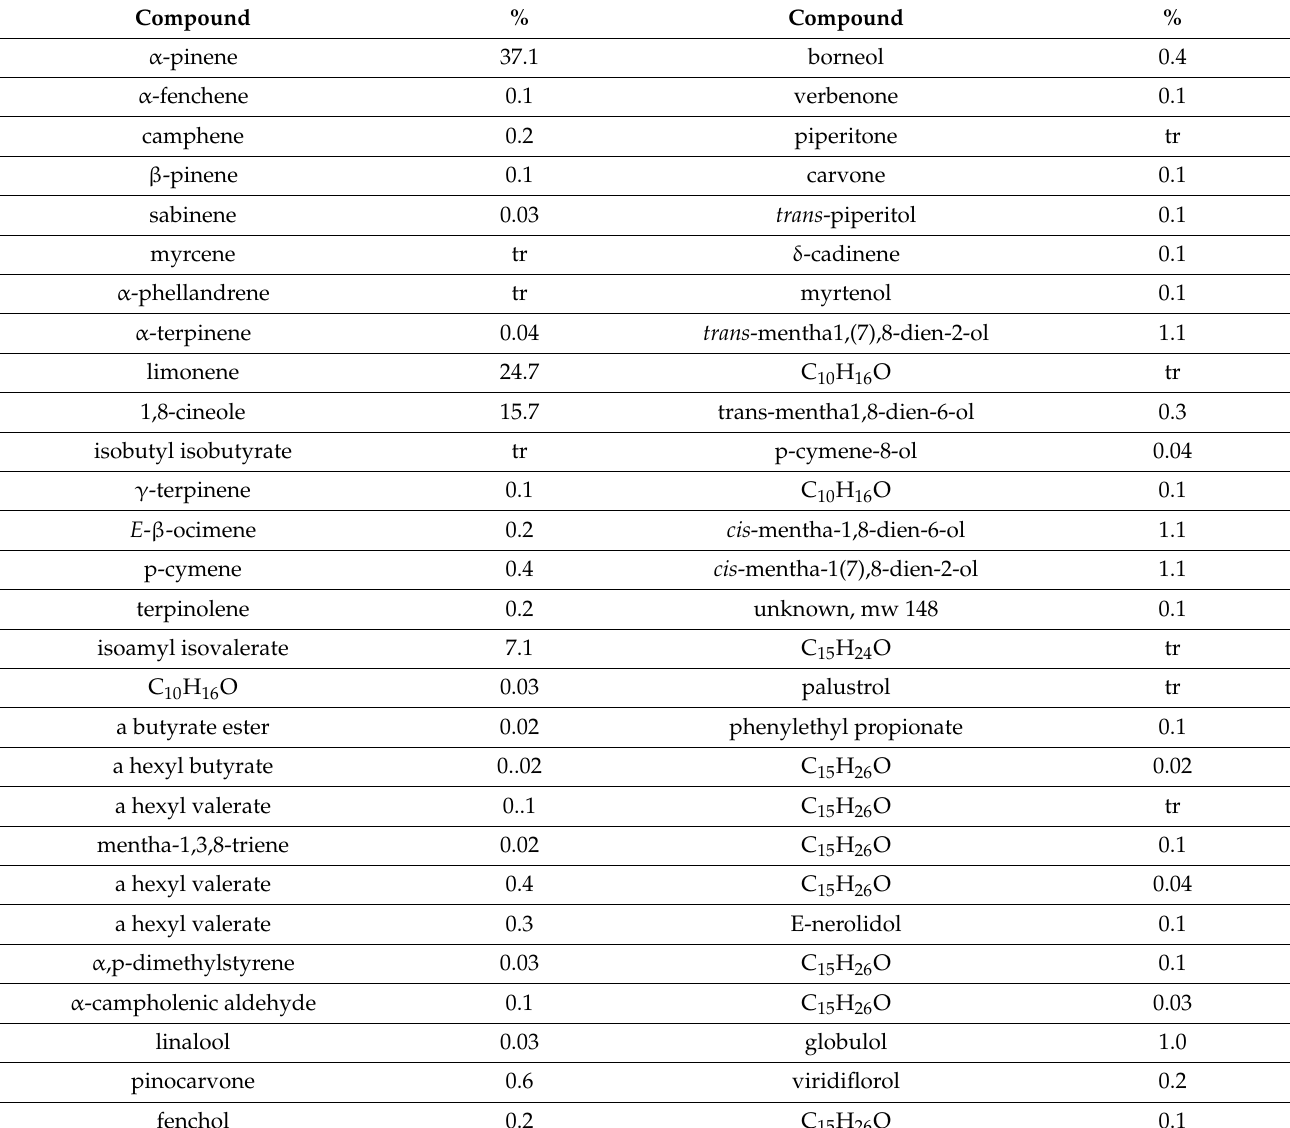
Table 13. Compounds identified in the leaf oil of Backhousia subargentea